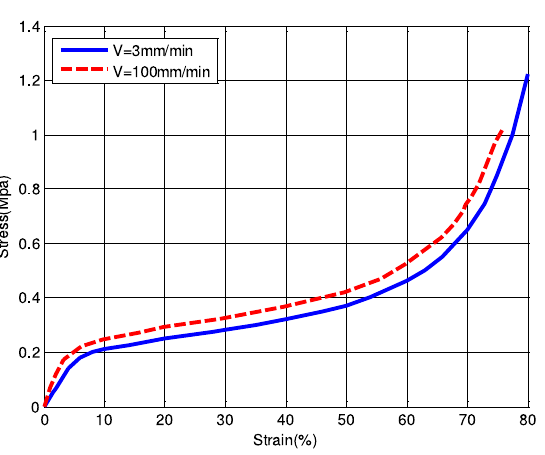
Figure 5. Stress-strain curves of elastomeric EPDM foam under quasi-static loadings in two rates.